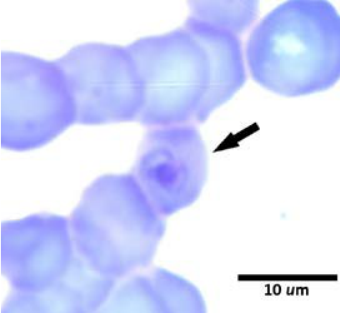
Figure 2: Large piroplasm in a red blood cell (arrowhead) of the peripheral blood smear (stained in Diff-Quik) made from the black